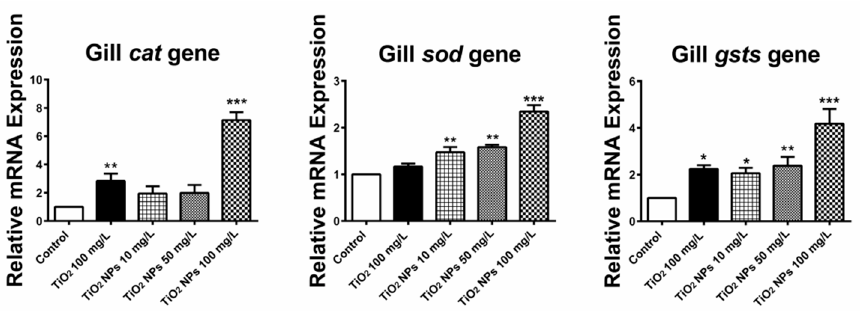
Figure 7. Change in the relative expression level of three antioxidase related genes (CAT, SOD and GSTS) in gill tissue. *, ** and *** indicate statistically significant differences from control values at p < 0.05, p < 0.01 and p < 0.001, respectively.